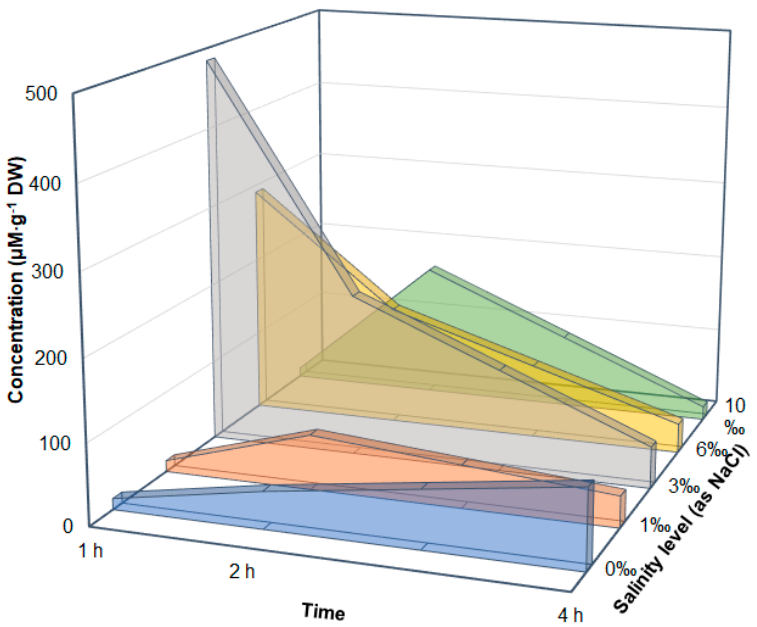
ff erent salinity